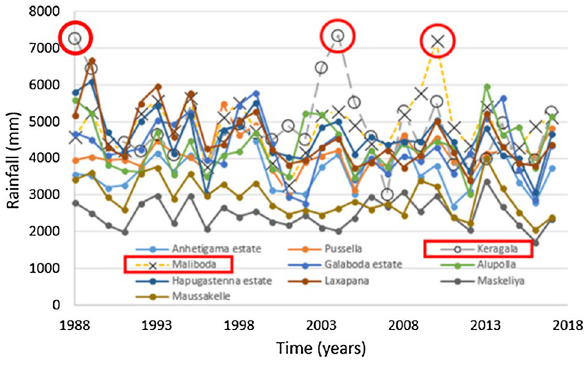
Fig. 2 Annual rainfall variation over 30 years